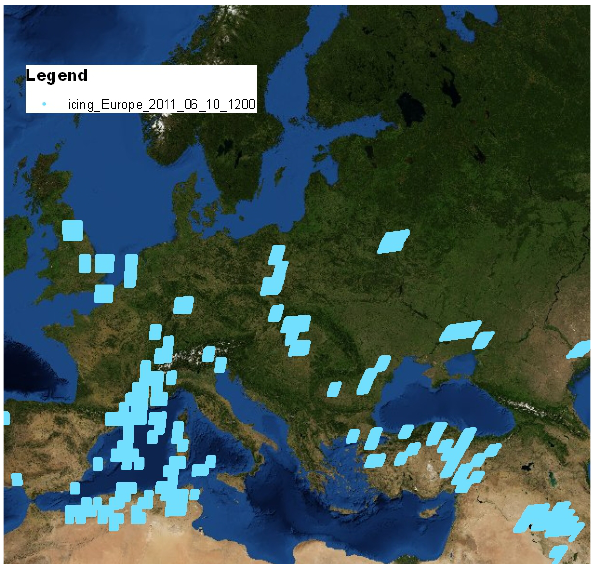
Figure 4. Icing conditions occurring 10 June 2011, 12:00UTC.